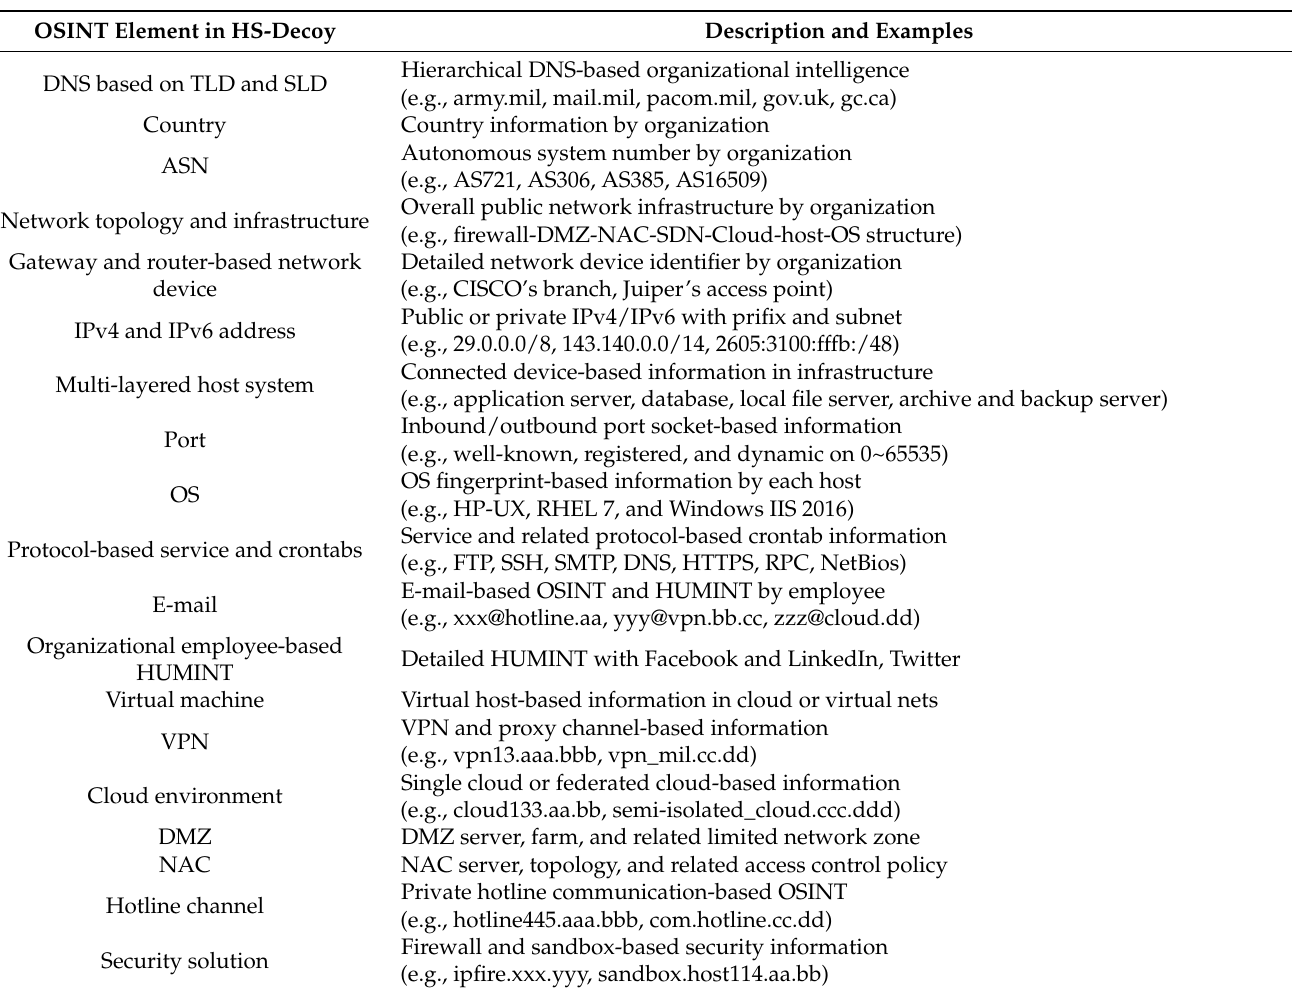
Figure A4. Hierarchical compound metric tree based on defenders’ perspective. Table A1. Overview of OSINT composition with DNS enumeration for LPC-MTD and HS-Decoy.